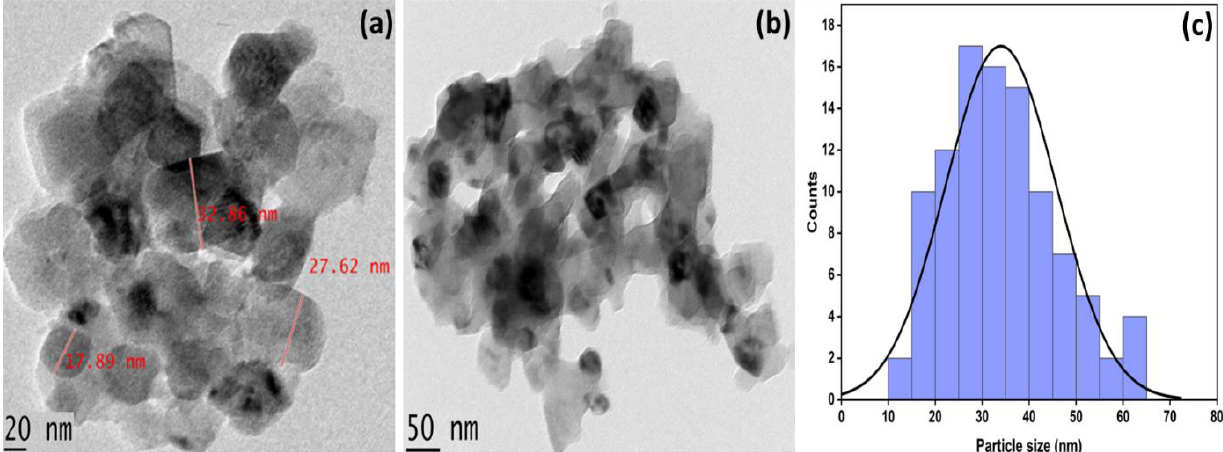
Figure 6. TEM graphs of ( a ) 20 nm, ( b ) 50 and ( c ) particle size distribution curve of the CaO−ZrO 2 catalyst.